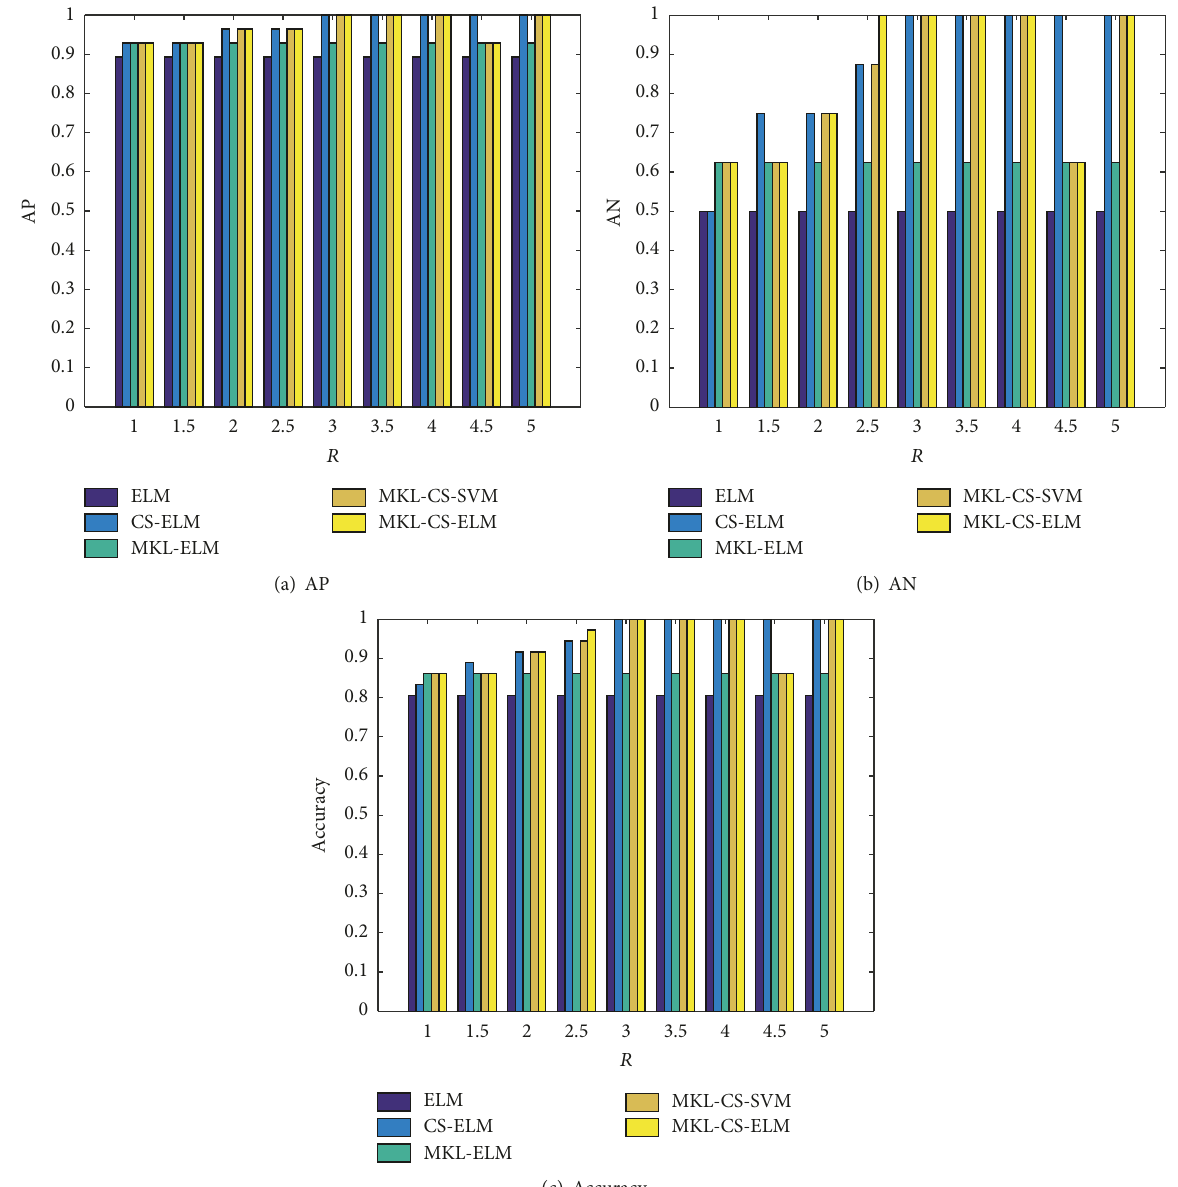
Figure 8: The recognition results of five classification models in threshold